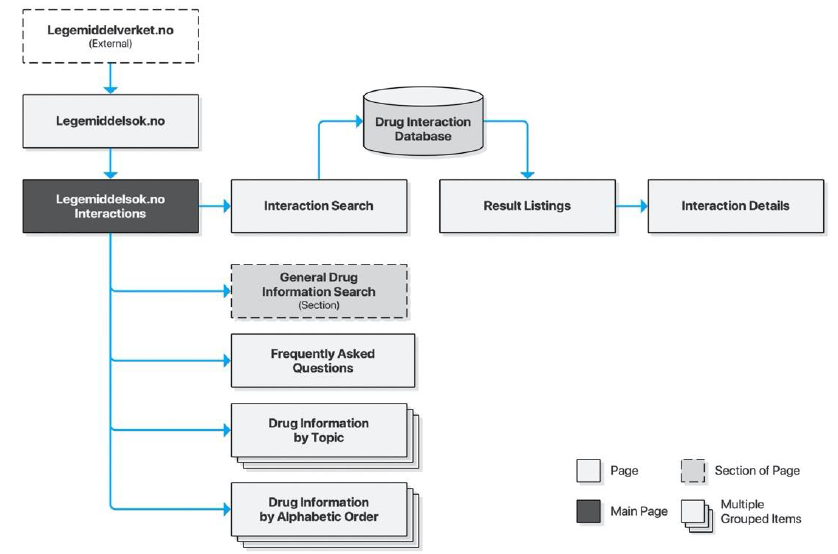
Figure 5. Sitemap for Legemiddelsok.no.